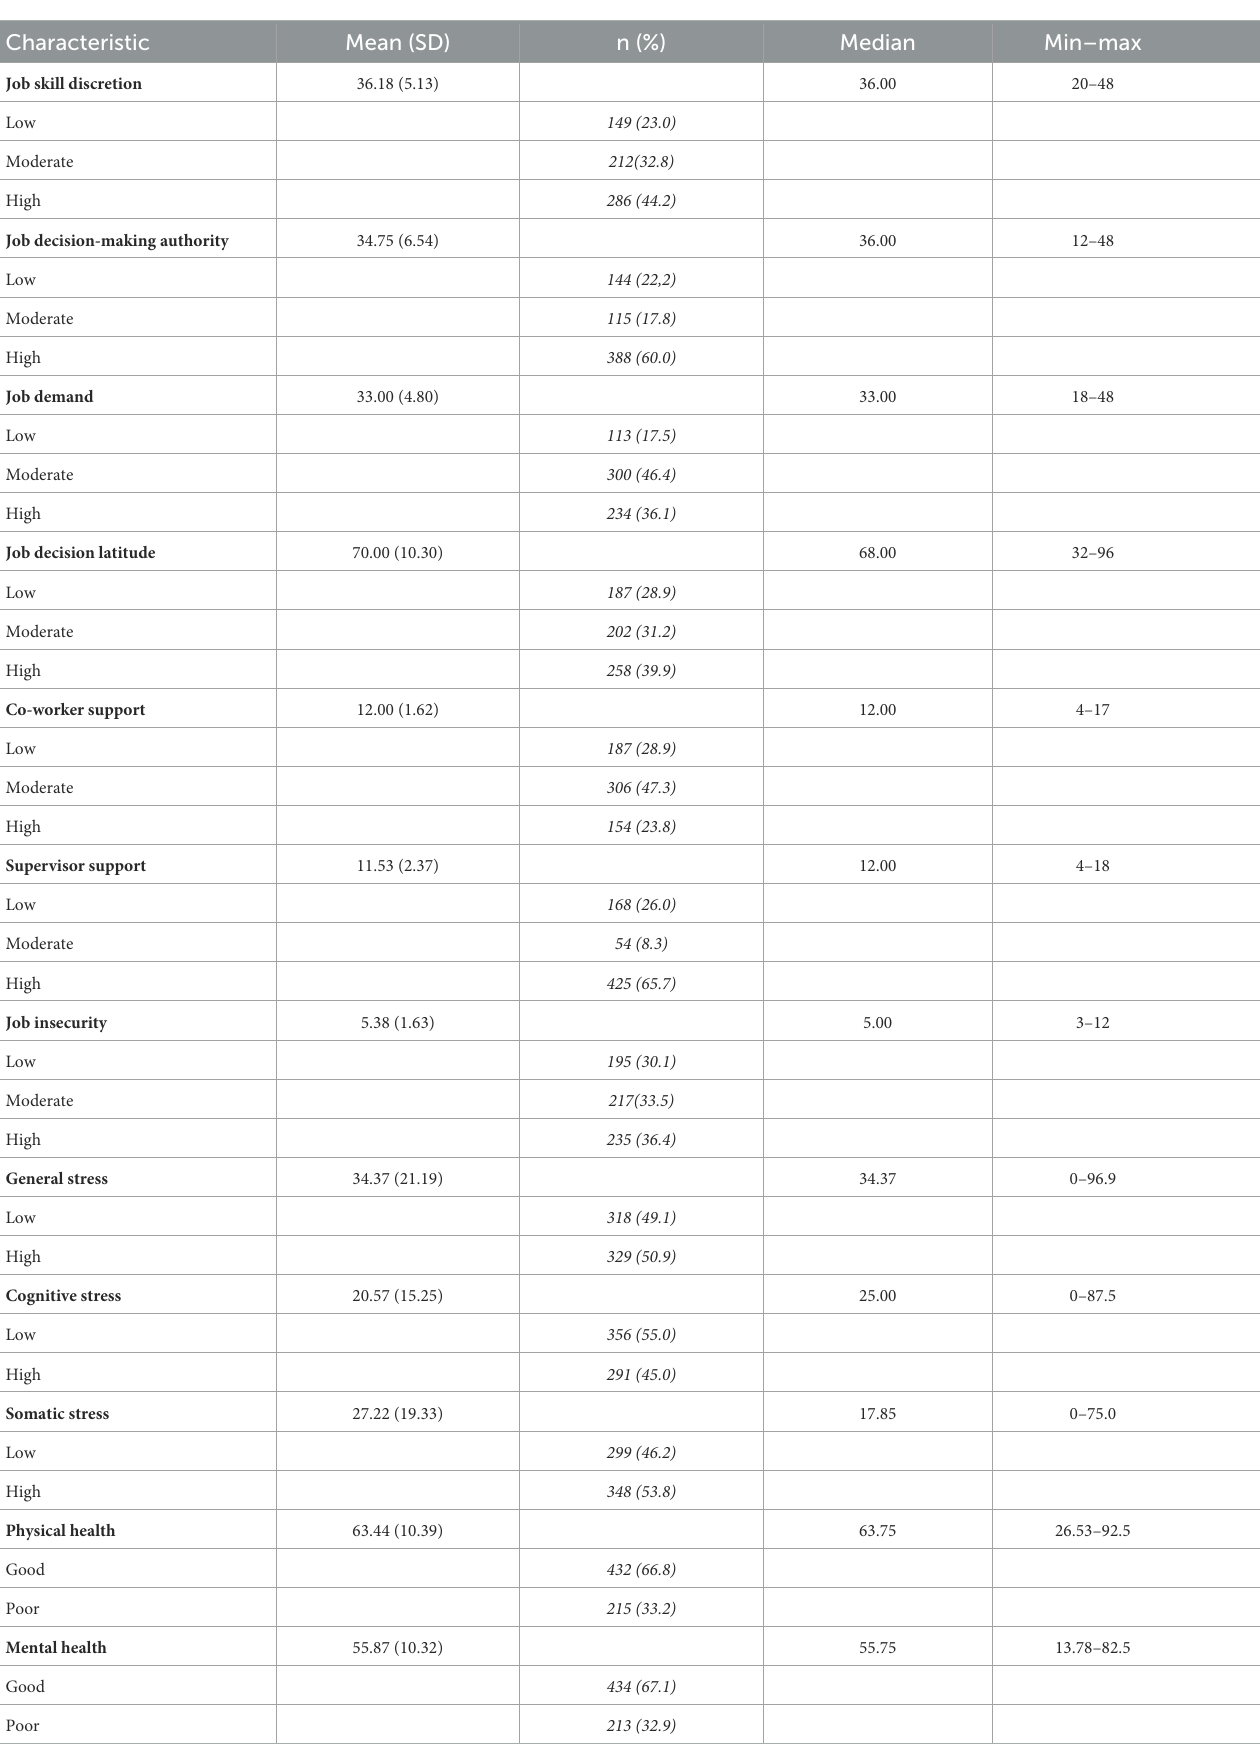
TABLE 2 Descriptive statistics of psychosocial work environment and perceived health